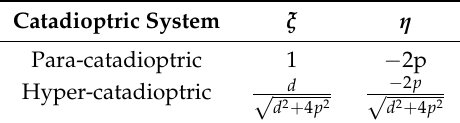
Table 4. Definition of ξ and η for central